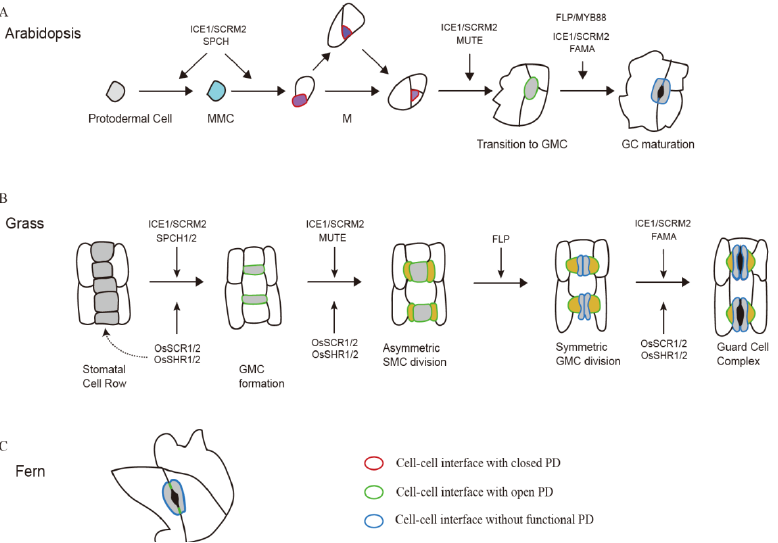
Figure 1. Schematic diagrams showing key regulators and symplastic connections during stomatal development in Arabidopsis , Grass and Fern. ( A ) Stomatal development in Arabidopsis . A protodermal cell converts to the stomatal lineage when it becomes a meristemoid mother cell MMC, then the MMC undergoes an asymmetric division to produce a smaller meristemoid (purple) and a larger stomatal lineage ground cell (SLGC; white). The meristemoid (M) undergoes additional self-renew- ing asymmetric divisions or differentiates into a guard mother cell (GMC; light gray). The GMC divides symmetrically to form a pair of guard cells (GCs; gray). Five bHLH transcription factors, SPCH, MUTE, FAMA and their heterodimeric partners ICE1 and SCRM2 regulate fate transitions during stomatal development. SPCH and ICE1/SCREAM2 mediate both entry and [48]amplifying asymmetric divisions, while MUTE and ICE1/SCREAM2 mediate the transition from M to GMC fate. FAMA, FOUR LIPS (FLP)/MYB88, and ICE1/SCREAM2 control the GMC symmetric division and GC maturation. Plasmodesmata (PD) were observed in ventral walls between sister guard cells and, most importantly, between immature GCs and epidermal cells, but degenerated until GC be- came mature. However, the PD are supposed to be closed to block the intercellular movement of transcription factor SPCH before GCs formed. ( B ) Stomatal development in grasses. The develop- mental process of stomata in grasses can be divided into five steps: (1) specification of the stomatal file, (2) GMC formation, (3) asymmetric division of subsidiary mother cells (SMCs) to generate SCs, (4) GMC symmetric division to form two immature GCs, (5) maturation of two dumbbell-shaped GCs flanked by two triangle-shaped SCs. SPCH has been duplicated and both homologues act to induce asymmetric divisions and promote the acquisition of stomatal lineage identity, in which SPCH2 plays a predominant role. The grass MUTE has a unique character to move from GMCs into SMC where it functions to promote the asymmetric division of SMCs to form SCs. FAMA and FLP regulate the symmetric division of GMCs and the maturation of GCs. Like the Arabidopsis counter- parts, grass ICE1/2 proteins form heterodimers with SPCH1/2, MUTE, or FAMA, respectively. In rice, SCARECROW (SCR)1/2 and SHORTROOT (SHR)1/2, have been shown to act together to reg- ulate the initiation of stomatal lineage cells, formation of SCs, and maturation of GCs. Before the complete maturation of stomata complex, there are functional PD connecting GMCs with surround- ing cells. However, PD are just present between ordinary epidermal cells and SCs when mature GCs formation, but not GC-GC and GC-SC interfaces. ( C ) Stomata of fern. A few long and narrow PD are present between two GC cells in fern, allowing the fluorescent dyes slowly move from guard cell to another, but the electrical conductance of the PD is not high enough to provoke membrane potential changes.